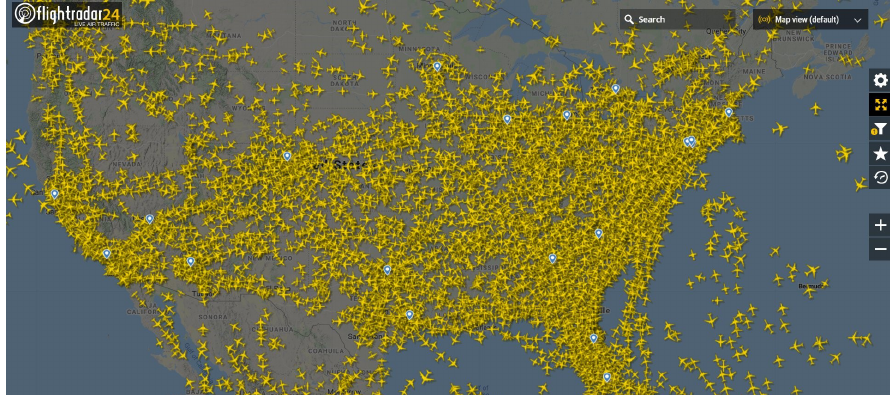
Figure 2. Commercial flight traffic above the US pre COVID-19 outbreak, 1 March 2020 [7].